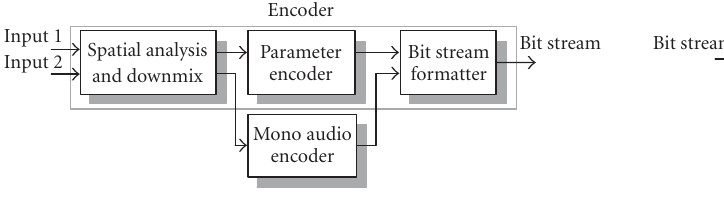
Figure 2: Structure of the parametric-stereo decoder. The de- multiplexer splits mono and spatial parameter information. The mono audio signal is decoded and fed into the spatial synthesis stage, which reinstates the spatial cues based on the decoded spa- tial